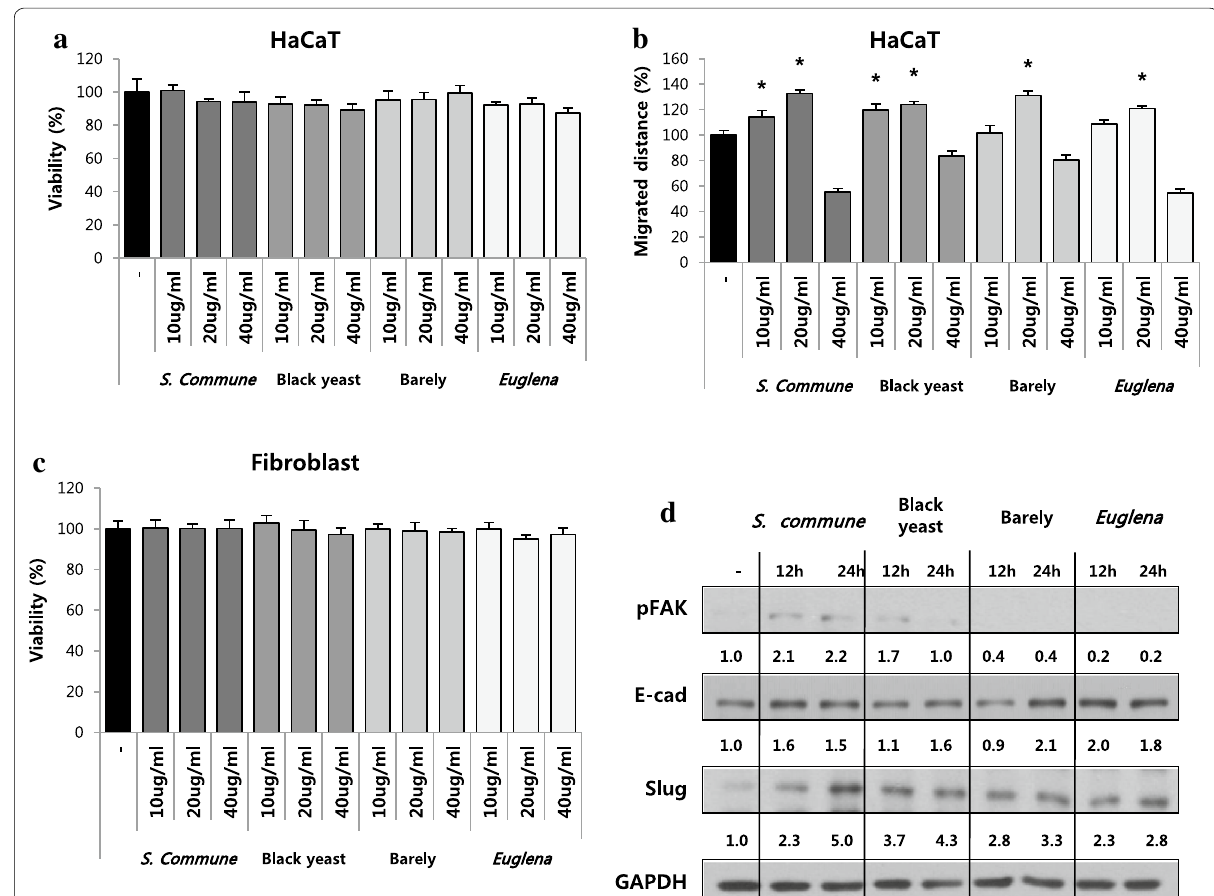
Fig. 2 The comparision of four types of beta-glucans in structure and effect on skin cells. a Viabilty of HaCaT and c fibroblast treated with beta-glucans derived from S. commune , black yeast, barely, and euglena. The cells (2 10 4 cells/ml) were seeded and treated with 0–40 μg/ml × beta-glucan for 24 h. Viability of cells was measured using the MTT solution (5 mg/ml). b Scratch wound healing assay with HaCaT treated as described in a after 24 h. HaCaT cells (7 10 4 cells/well) were seeded on 48 well plate and a scratch was made on the cell monolayer by drawing a × pipette tip across the well, and then treated with 0–40 μg/ml. Migration distance was measured using the ImageJ program. *P < 0.05 as compared to the control. d Western blotting for HaCaT cells treated with four types of beta-glucans. Cell lyastes were isolated using RIPA solution and protein concentration was measured by BCA assay. Phospho-FAK, E-cadherin, and slug expression were measured and their levels were normalized to GAPDH. The values indicate intensities of protein expression with respect to that of the loading